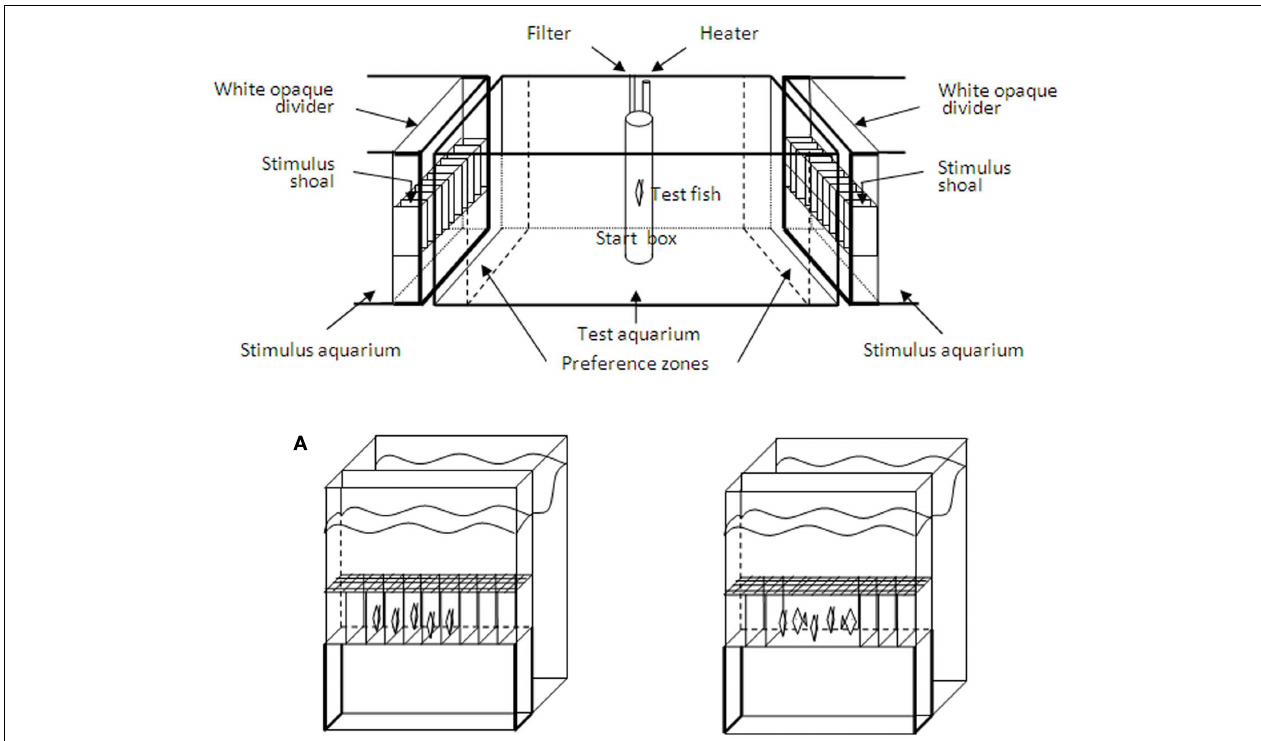
stimulus compartments utilized in Experiment 2.To control for the overall swimming activity of the shoals, the stimulus compartments were divided into 10 sectors by transparent partitions and each fish of the stimulus shoals was individually placed into the adjacent sectors. In the control treatments (one shoal more stationary and the other moving), the central partitions were removed and fish in one of the shoals were allowed to swim freely in that space (illustrated in the case of 5 vs. 5 fish in the Figure). Presentation of the stimulus shoals in the stimulus compartments was balanced between the two stimulus